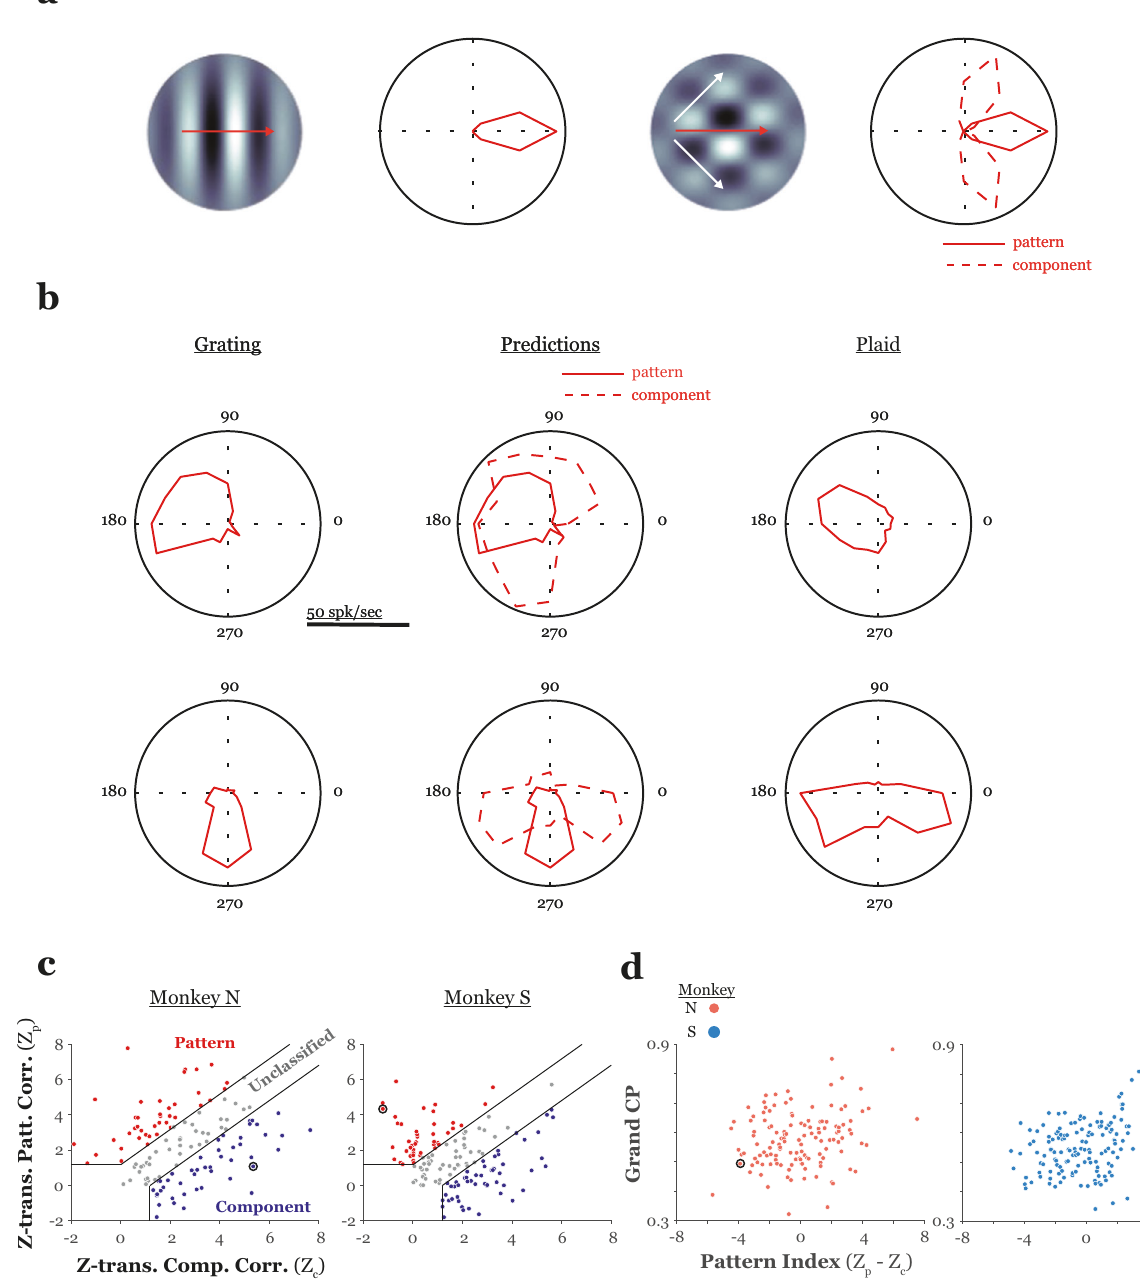
Fig.7|RelationshipbetweenMTpattern-motionsensitivityandchoice-related activity in the plaid segmentation task. a Schematic illustration of pattern- componenttuningstimuliandhypotheticalgrating(left)andplaiddirectiontuning curves (right) (see Materials and Methods). Brie fl y, if a cell integrates across plaid components to signal pattern motion, then one would expect tuning curves to be identical for singlegrating and plaid stimuli (last column, solid curve).Conversely, ifacelldidnotintegratecomponentdirectionstosignalpatternmotion,onewould expect a bi-lobed tuning curve, with a peak for each direction of plaid motion that translates a single component in the unit ’ s preferred direction ( fi nal column, dashed curve). b (left) Sine grating direction tuning curves for the unit shown in Figs. 3 and 4 (top row – unit from Figs. 3a, b and 4a, b (top); bottom panel – unit from Figs. 3c, d and 4a, b (bottom)). (middle) Pattern and component predictions calculatedfrom the gratingtuning pro fi les. (right)Plaidtuning for these units. The